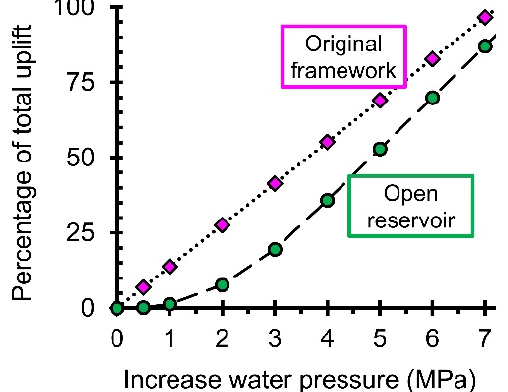
Figure 7. Relation between the amount of uplift at a north–south coordinate of 3.375 km and the increase in water pressure. The uplift is presented as a percentage of the maximum calculated amount of uplift at 3.375 km. The relation for the framework developed in [17] is presented by purple diamonds, and the model assuming an open reservoir is presented by green circles.